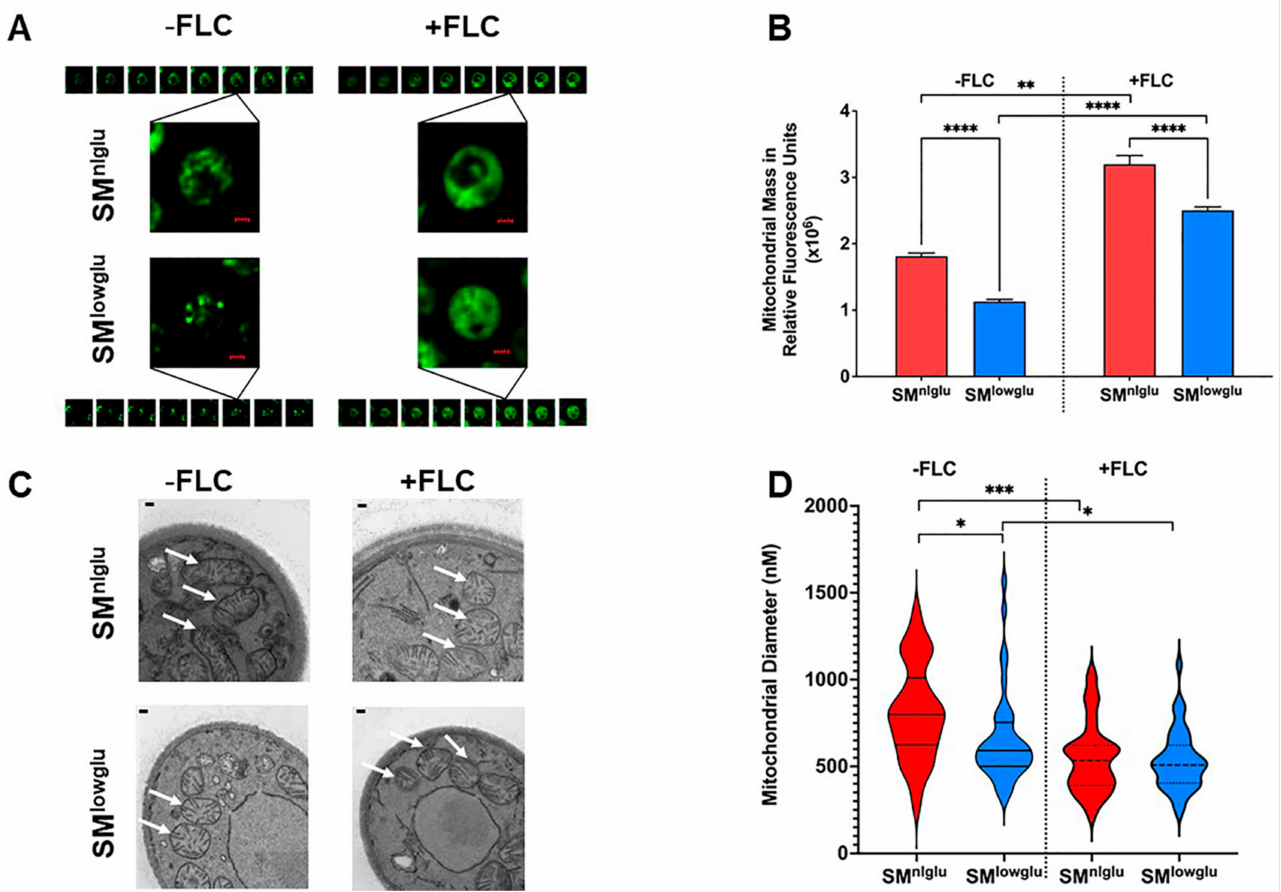
Figure 3. Effects of low glucose on mitochondrial structure. ( A ) Deconvolved fluorescent microscopy images show the difference in mitochondrial morphology in the presence (+FLC) and absence ( − FLC) of 1 µ g/mL FLC in KN99 α cells in SM nlglu and SM lowglu media. Mitochondria were stained with MitoTracker Green FM. Each fluorescent field was imaged as a z-stack with 20 equal slices. Of the 20 slices, 8 slices for each condition are shown here. Scale bars in red = 1 µ m. ( B ) Measurement of mitochondrial mass per 10 6 KN99 α cells grown in SM nlglu (red bar) and SM lowglu (blue bar) media in the presence (+FLC) or absence ( − FLC) of 1 µ g/mL of FLC. Mitochondria were stained with MitoTracker Green FM and fluorescence was measured. The assay was performed in biological triplicate. Error bars represent the standard deviation in the triplicate values. Student’s t -test with Welch’ correction was performed to determine the p -value (**** p < 0.0001, ** p = 0.0011). ( C ) TEM images of mitochondrial cross-sections of KN99 α cells grown in SM nlglu and SM lowglu media in the presence (+FLC) or absence ( − FLC) of 1 µ g/mL of FLC showing different cross-sectional morphology of mitochondria. Scale bars in white = 100 nm. White arrows point to the mitochondrial structures as observed under TEM ( D ) Fiji was used to quantify the cross-sectional diameter of the mitochondria in SM nlglu and SM lowglu media in the presence (+FLC) or absence ( − FLC) of 1 µ g/mL of FLC. Forty mitochondria were measured from 30,000X zoom TEM images with a 500 nm scale bar. Student’s t -test with Welch’s correction was performed to analyze the p -values (* p < 0.05, *** p <